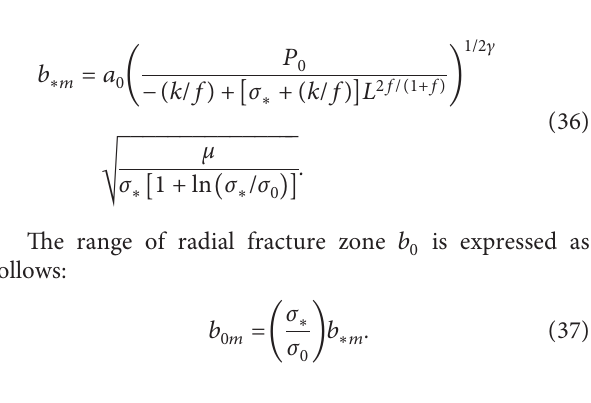
Figure 3: Scope of damage zones of cylindrical and spherical